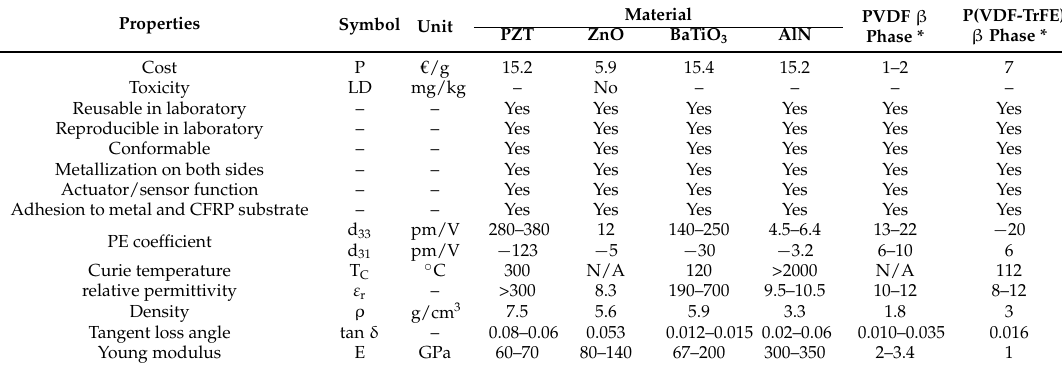
Table 1. Properties of most common PE